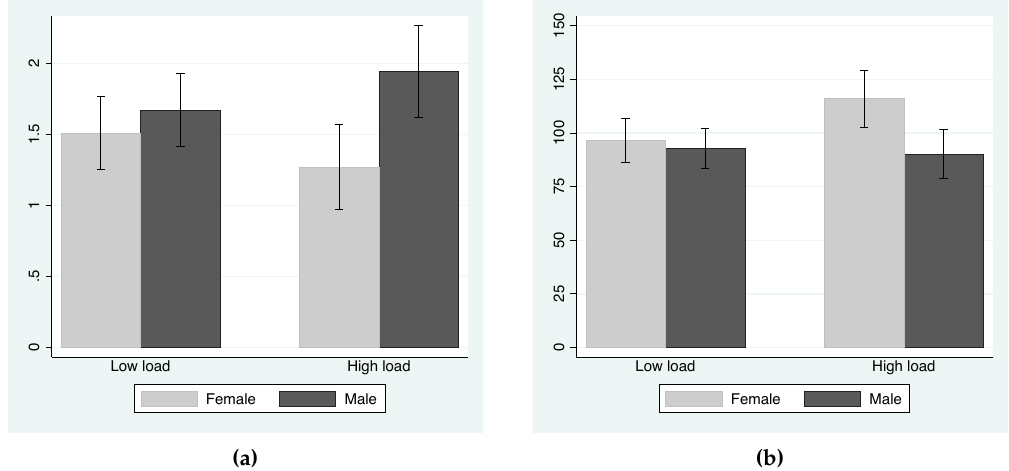
Figure 1. Mean CRT results by cognitive load and gender with 95% confidence intervals. ( a ) CRT score; ( b ) CRT answer time in